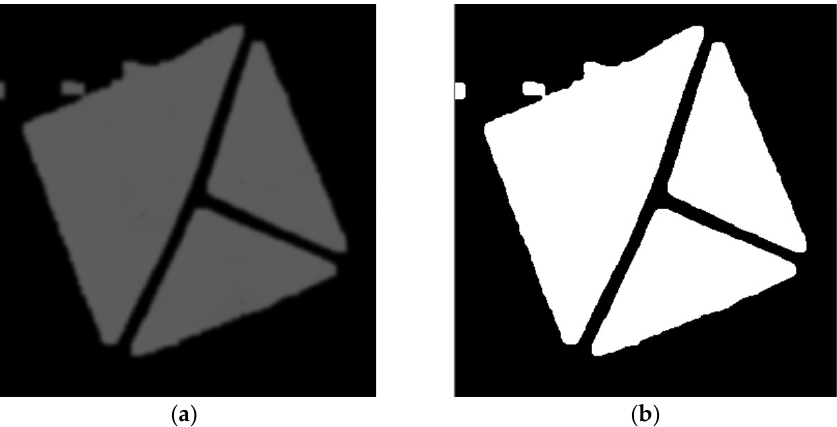
Figure 26. ( a ) image after applying Gaussian blur. ( b ) image after applying Otsu’s adaptive thresholding.